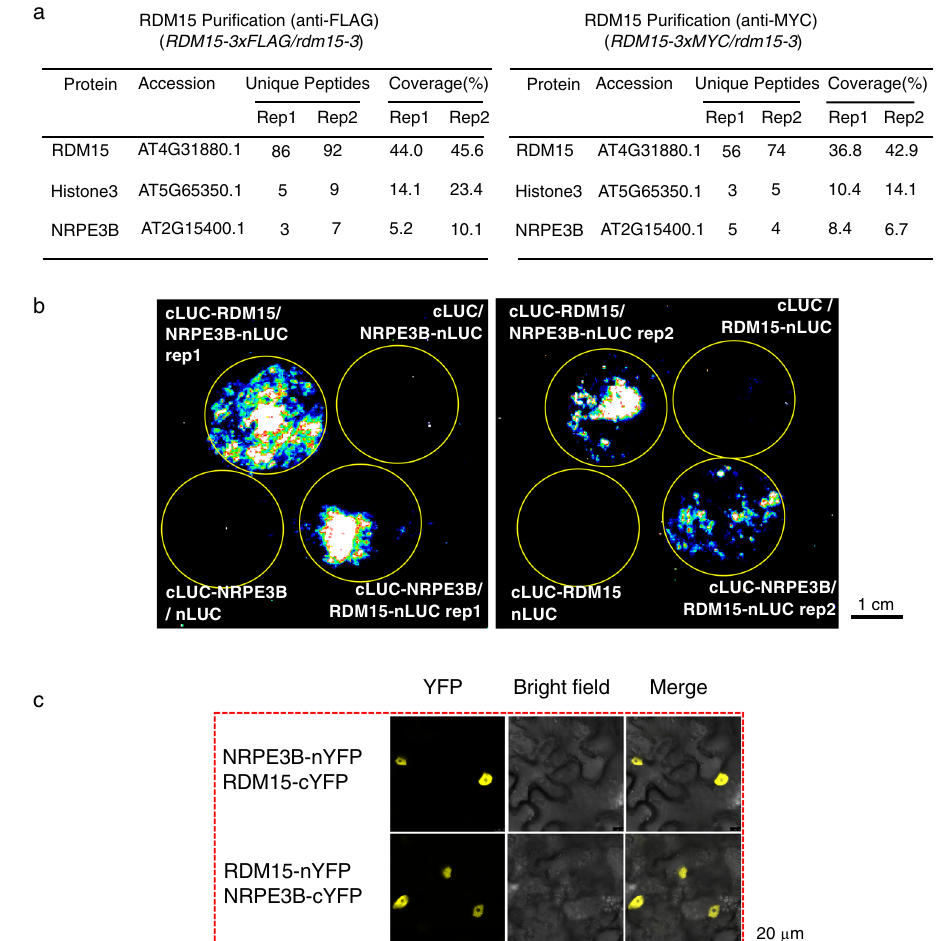
Fig. 4 RDM15 physically interacts with NRPE3B, a subunit exclusive to Pol V. a Detection of proteins associated with RDM15. LC-MS/MS was performed following immunoprecipitation of FLAG-tagged RDM15 and MYC-tagged RDM15. There were two biological replicates for each of the protein puri fi cations. b Tests of RDM15-NRPE3B interaction by split luciferase complementation assay in tobacco leaves. Circles indicate leaf regions that were in fi ltrated with Agrobacterium strains containing the indicated constructs. (Scale bar = 1 cm) c Analyses of RDM15-NRPE3B protein interaction by bimolecular fl uorescent complementation assay in tobacco leaves. Yellow fl uorescence indicates positive protein interaction. (Scale bar = 20 µ